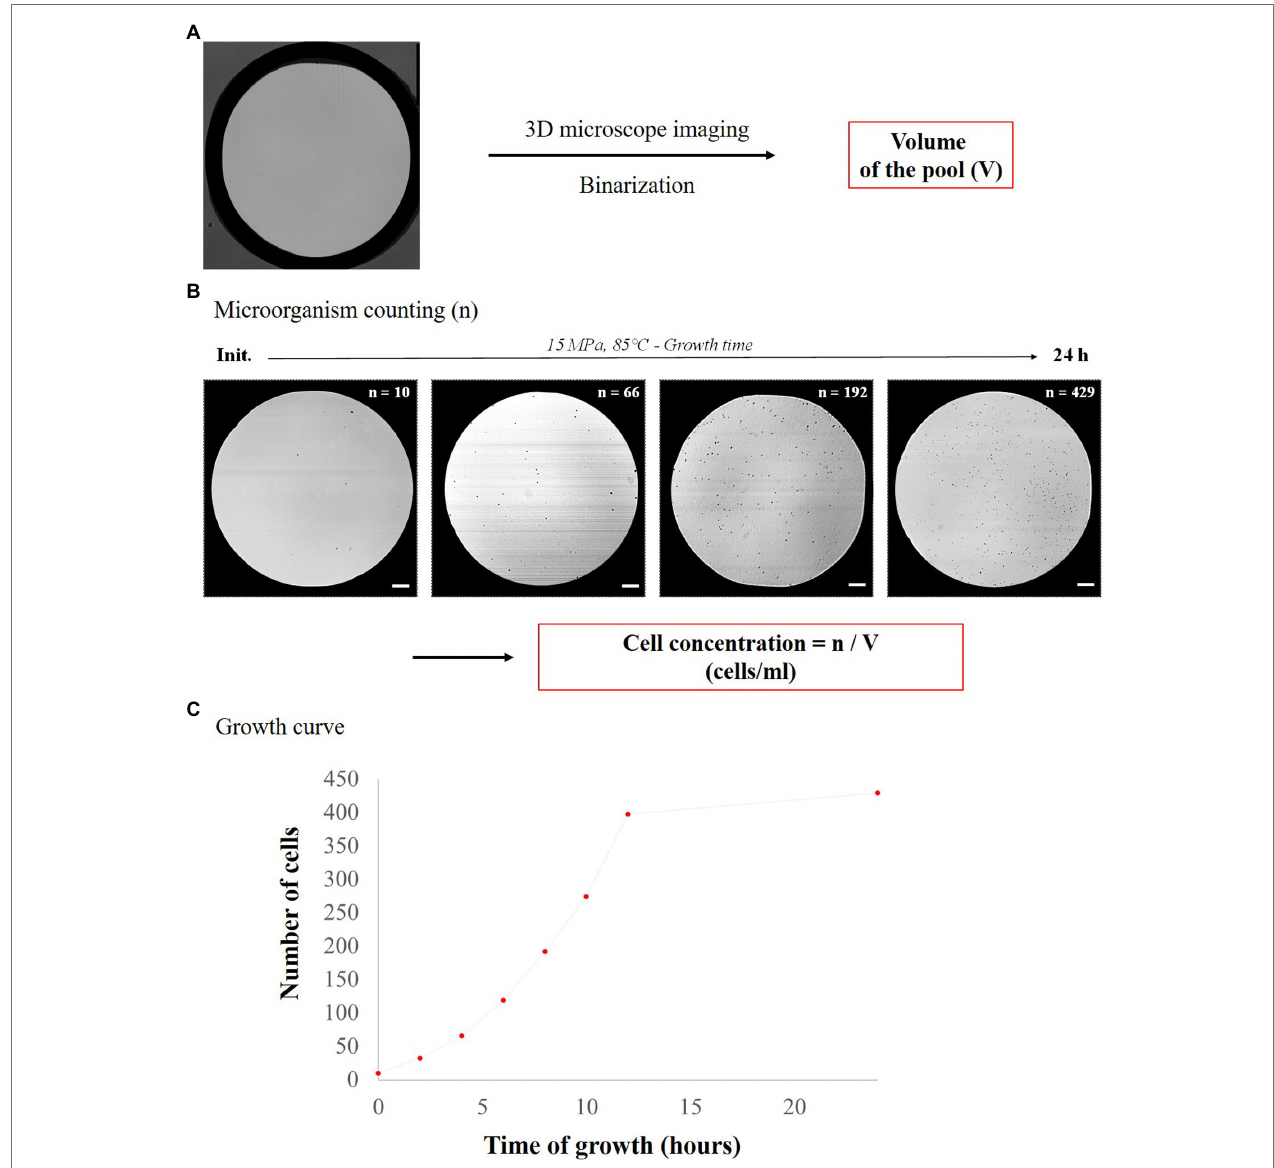
FIGURE 3 | Schematic flowsheet for determination of cell concentration in each pool. (A) Determination of micropool volumes using 3D confocal microscopy and ImageJ analysis and (B) examples of pictures of Thermococcus barophilus growth over time with the corresponding cell number ( n ) at 15 MPa and 85 ° C (scale bar = 25 μ m), allowing determination of cell concentration (cells.ml − 1 ). (C) Growth curve with cell number versus time (15 MPa, 85 °